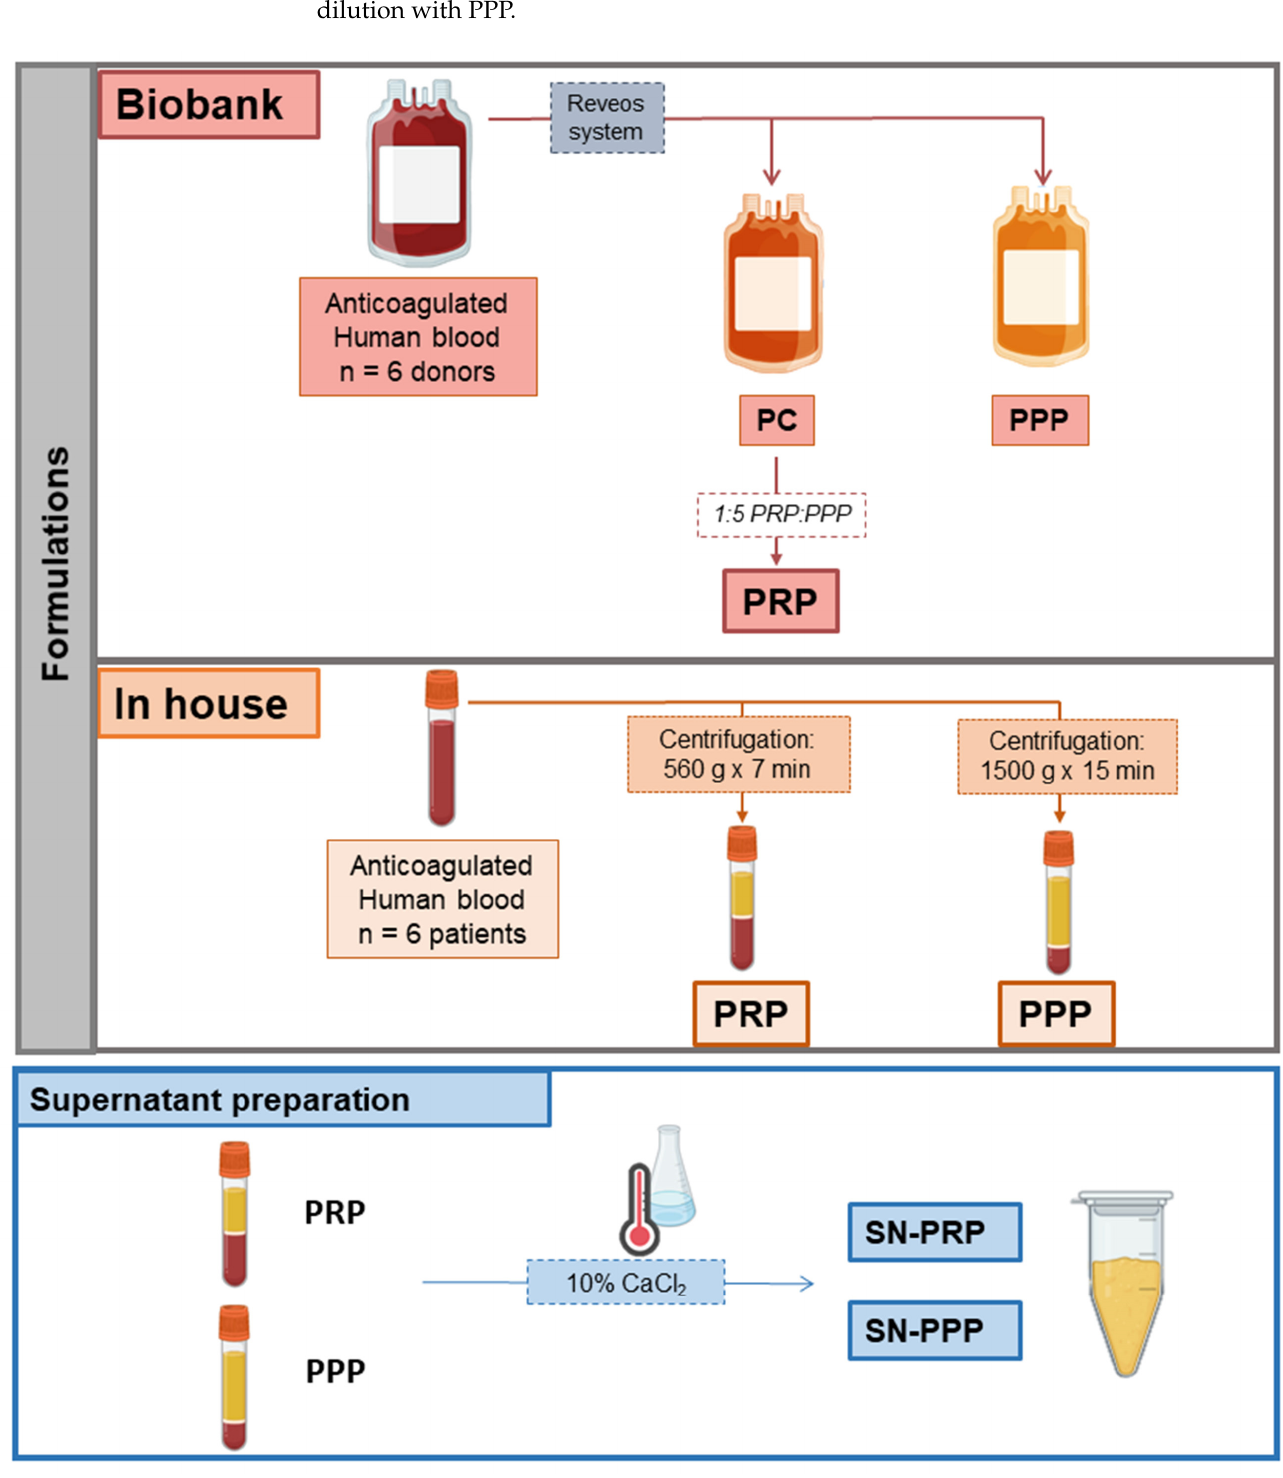
Figure 1. Diagram describing the procedure for platelet-derived products preparation. Biobank Platelet concentrate (PC) was diluted with platelet-poor plasma (PPP) to prepare platelet-rich plasma (PRP). In-house formulations were obtained by centrifugation of anticoagulated human blood. PRP and PPP supernatant (SN) were collected after CaCl 2 addition and incubation at 37 °C for 1 h.